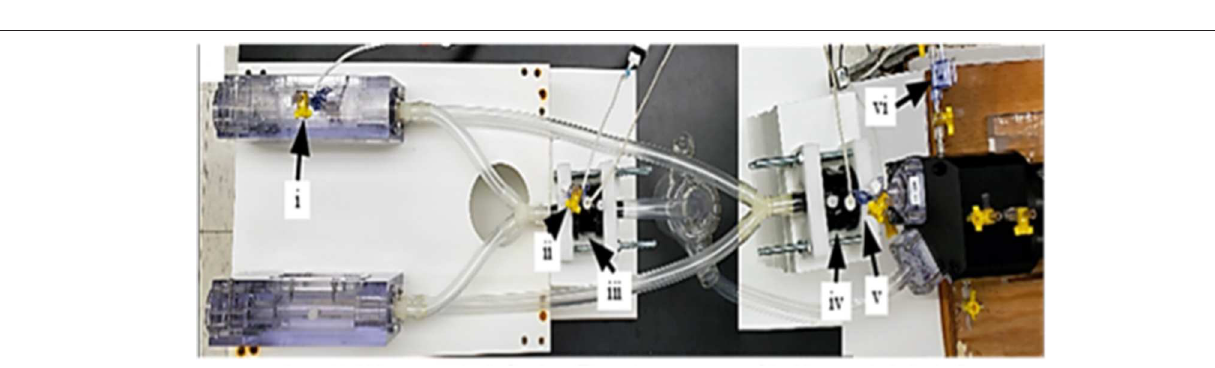
FIGURE 3 | Assembled bioreactor pulsatile flow loop. The major components of the bioreactor include: the (i) pressure sensor at bioreactor chamber, (ii) pressure sensor at bioreactor exit, (iii) flow probe at bioreactor exit, (iv) flow probe at pump exit, (v) pressure sensor at pump exit, and the (vi) pressure sensor inserted into pump-head